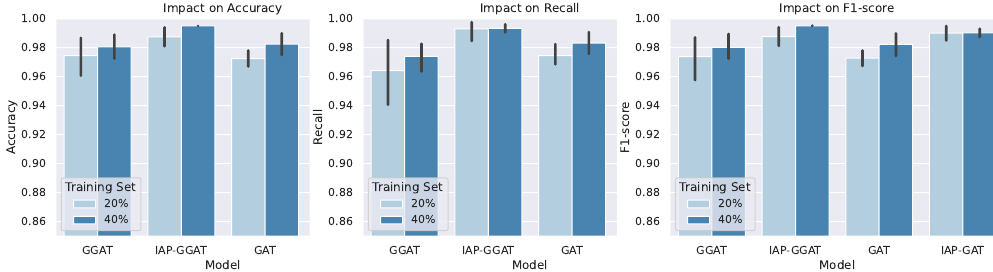
Figure 12. Comparisons amongst models trained on original and the reduced training sets in terms of 3 metrics, i.e., accuracy, recall and F1-score (from left to right). The figures show average model performance (in terms of the corresponding metric) on HNSC and LUSC datasets. Black sticks on top of the bars represent 95% confidence